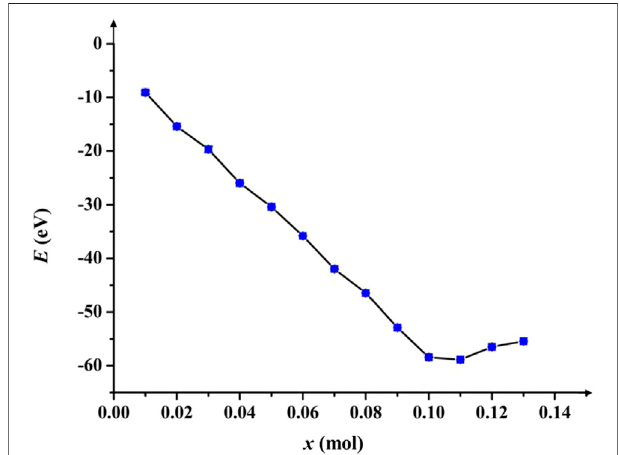
FIGURE 4 | Diagram about the relationship between E and x . The curve decreases until x < 0.12 mol, which demonstrates the lithiation/delithiation process can bene fi t from the appropriate Al doping amount. From x (cid:2) 0.11 mol, E begins to get bigger slightly. The small error bars mean our high- accuracy calculations.